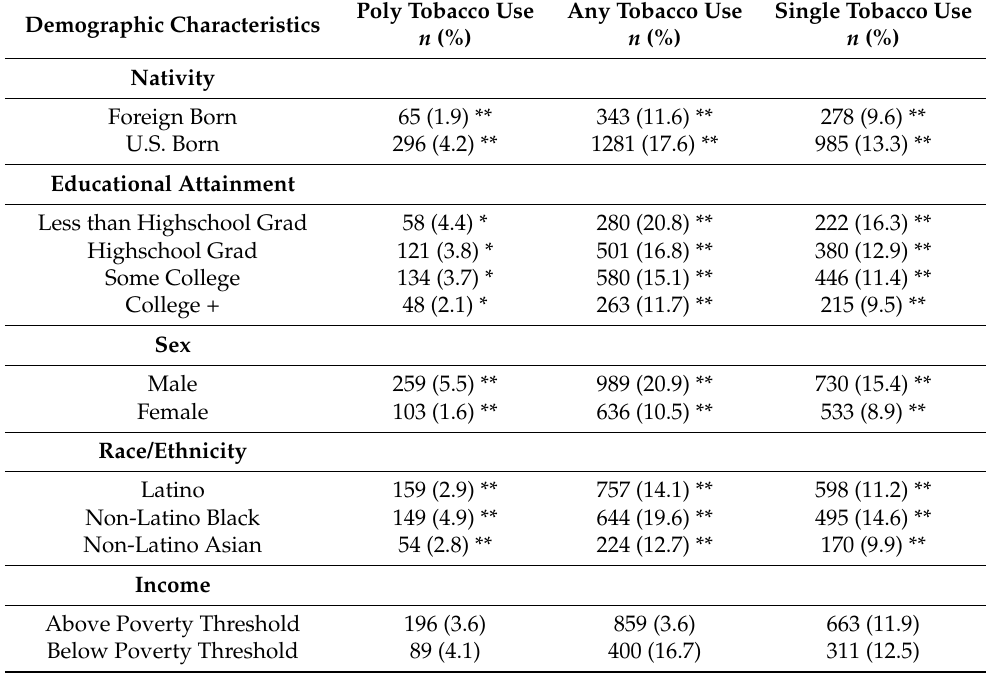
Table 1. Weighted prevalence estimates for demographic characteristics by any, poly, and single tobacco use—National Health Interview Survey (2015–2019), n = 9907. Demographic